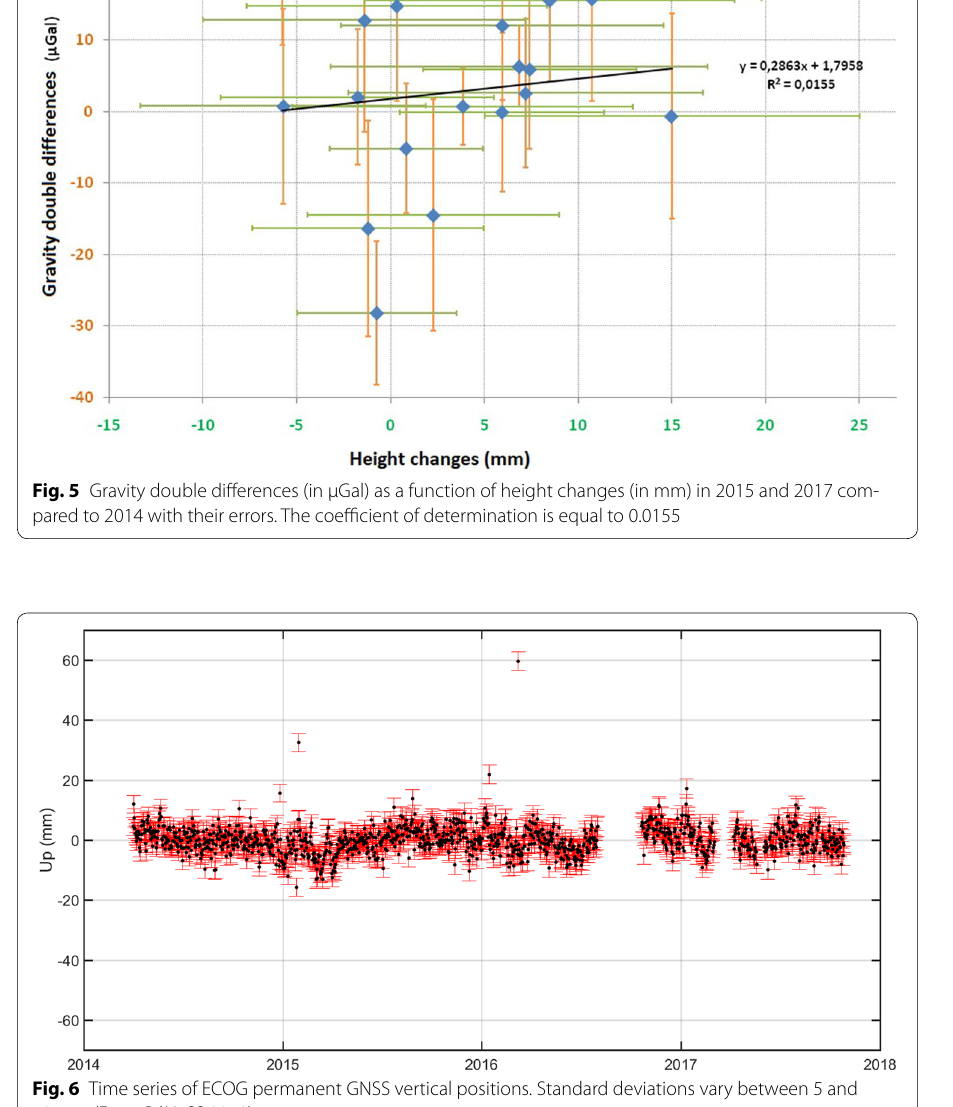
collected on the Rittershoffen geothermal plant with a TRIMBLE NETR9 receiver and TRIMBLE Zephyr antenna. GNSS data are processed with SCRS-PPP. The accuracy of the height changes retrieved from the GPS data varies between 5 and 10 mm. The GPS height changes (see Fig. 6) measured on the 15th of July 2015, 2016 and 2017 compared